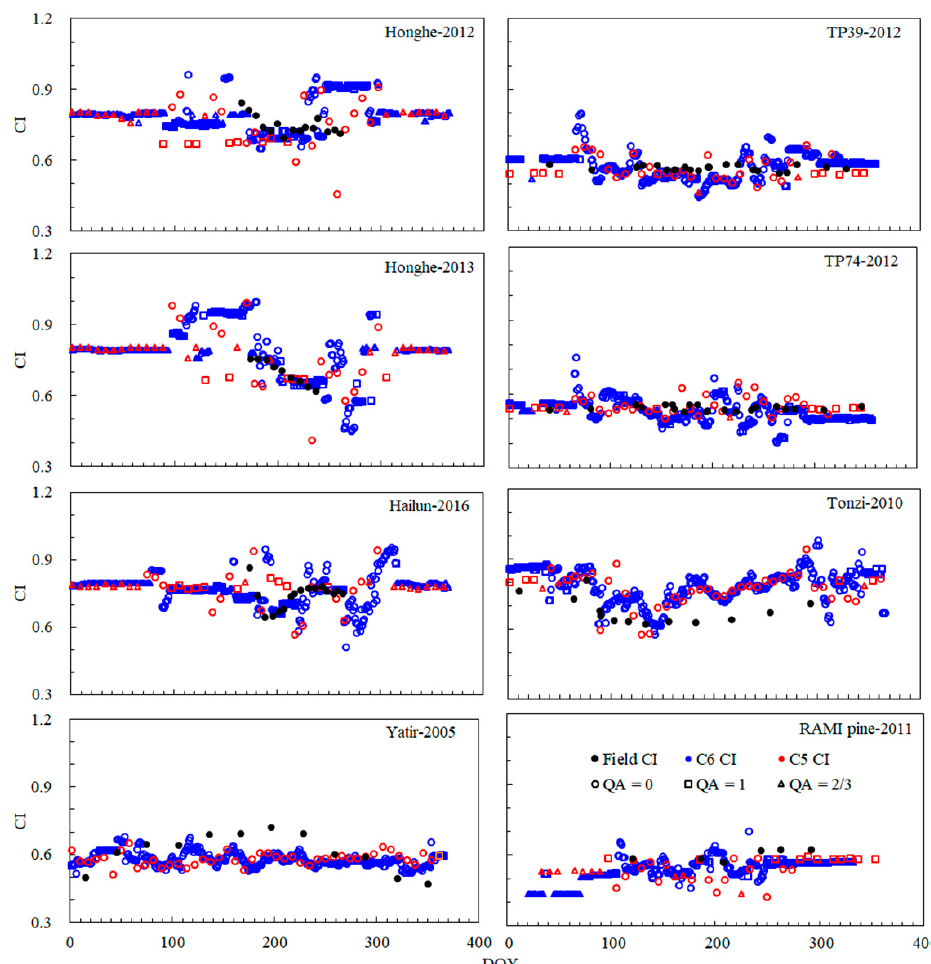
Figure 7. Comparison of seasonal variabilities in the C5 8 ‐ day CI and C6 daily CI with the field CI data. Details of the field CI data are shown in Table 2. Black dots denote the field CI data. Red and blue symbols indicate the C5 and C6 CIs, respectively. Circle, square, and triangle symbols represent the quality of the MODIS CIs (i.e., C5 and C6 CIs), which are the best quality (QA = 0), good quality (QA = 1), and backup algorithm retrievals (QA = 2/3), respectively.